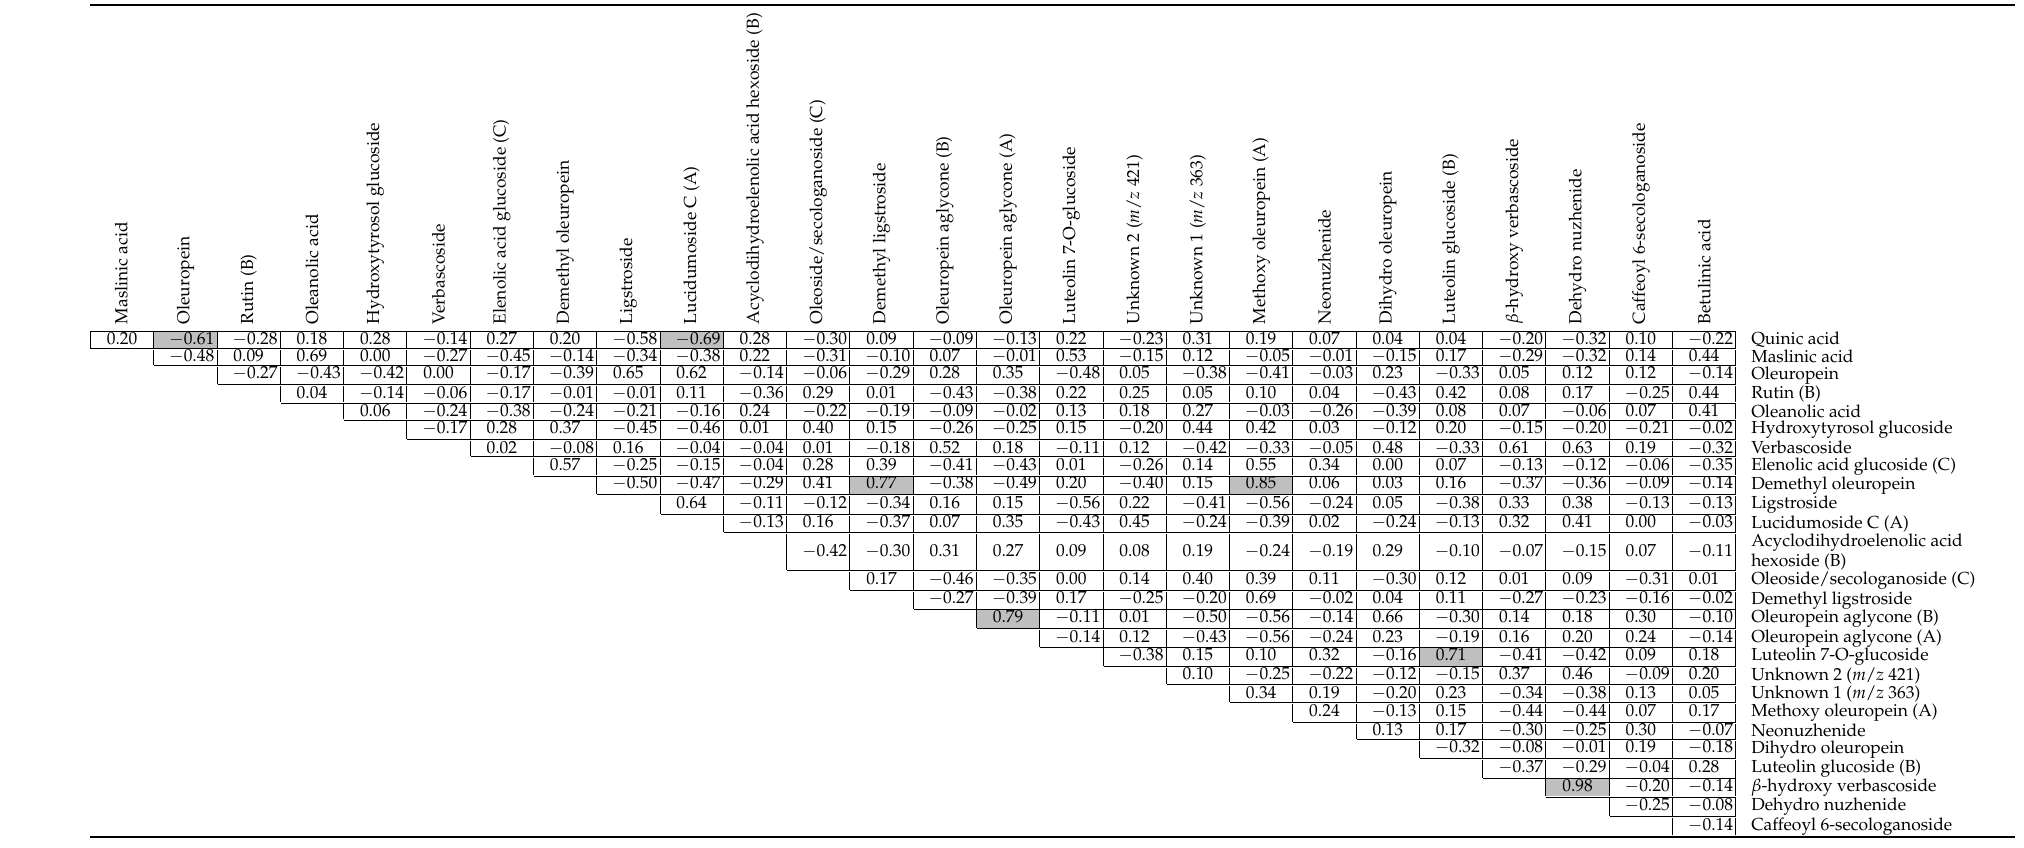
Table 4. Cross-correlation of secondary metabolites quantified in the progeny. Significant correlations at p < 0.001 are